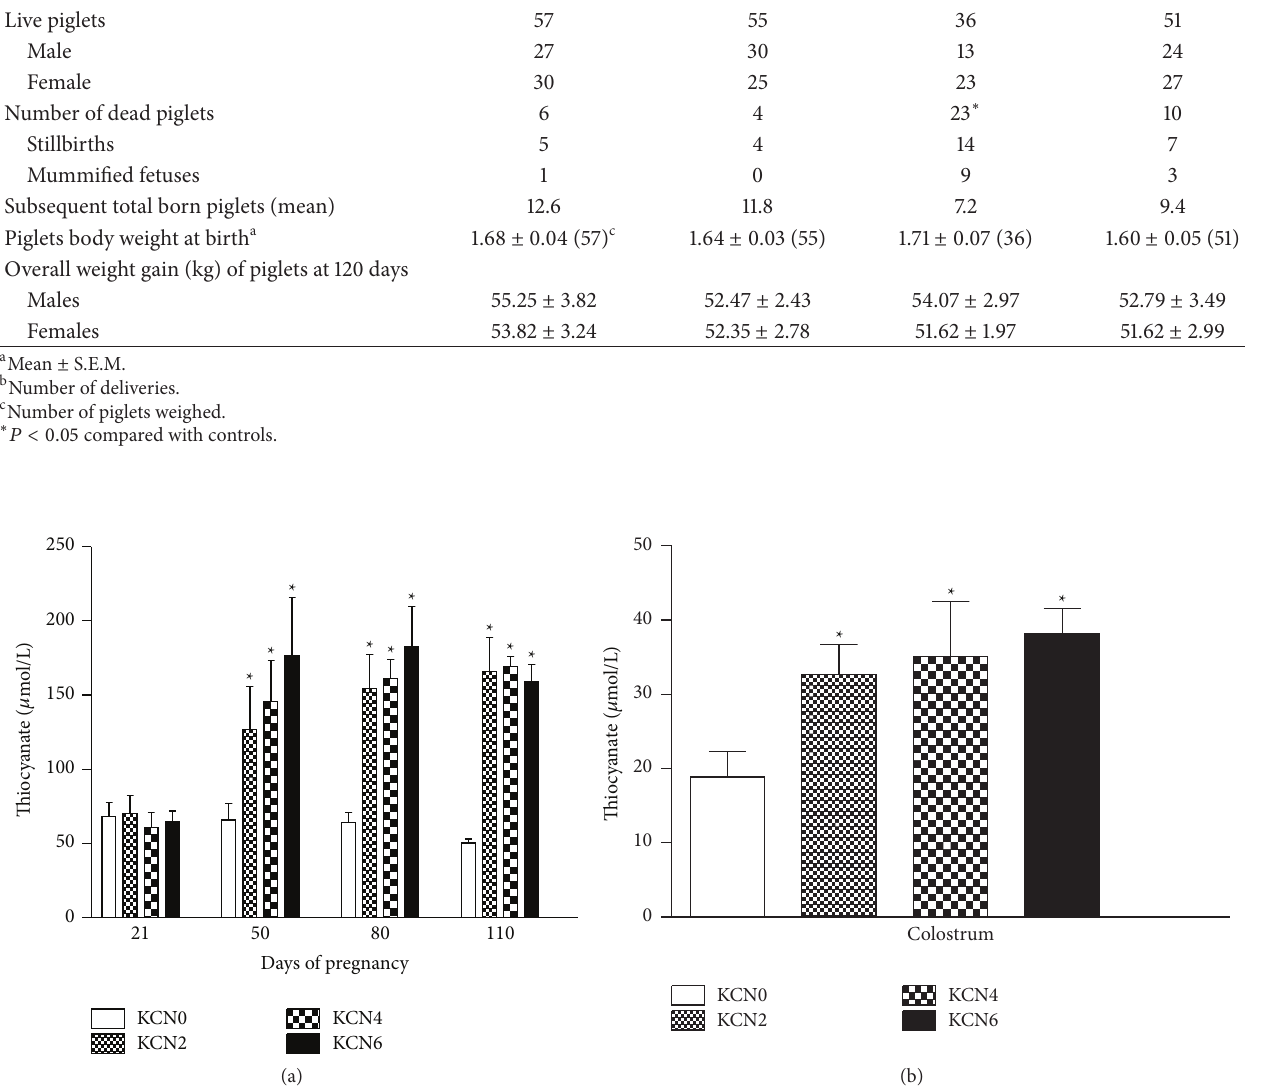
Figure 1: Thiocyanate levels (means ± S.E.M.) in plasma (a) and colostrum (b) of sows allocated into four treatment groups: KCN0, KCN2, KCN4,andKCN6thatreceived,respectively,0.0,2.0,4.0,and6.0 mg/kgofbodyweightofcyanidefromday21ofpregnancytoterm.* 𝑝 < 0.05 compared to